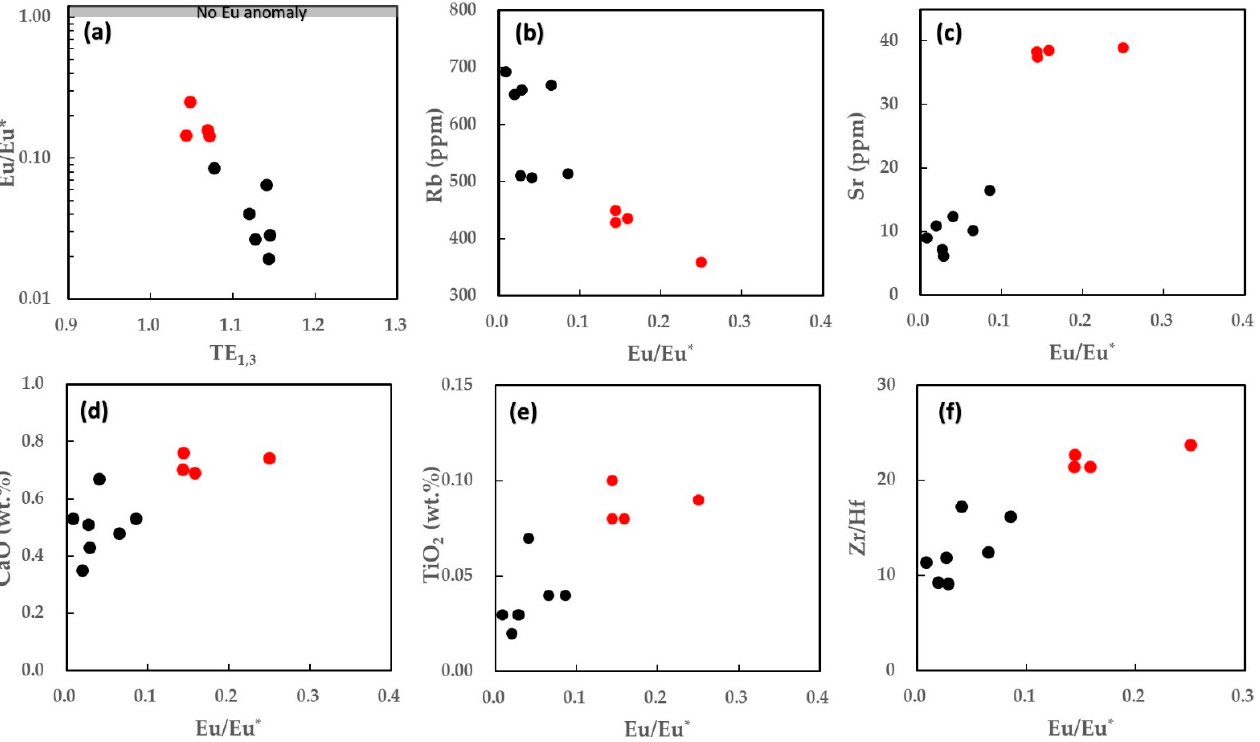
Figure 8. Eu/Eu* vs. ( a ) tetrad effects, ( b ) Rb, ( c ) Sr, ( d ) CaO, ( e ) TiO 2 , and ( f ) Zr/Hf variation diagrams; • A group; • B group.